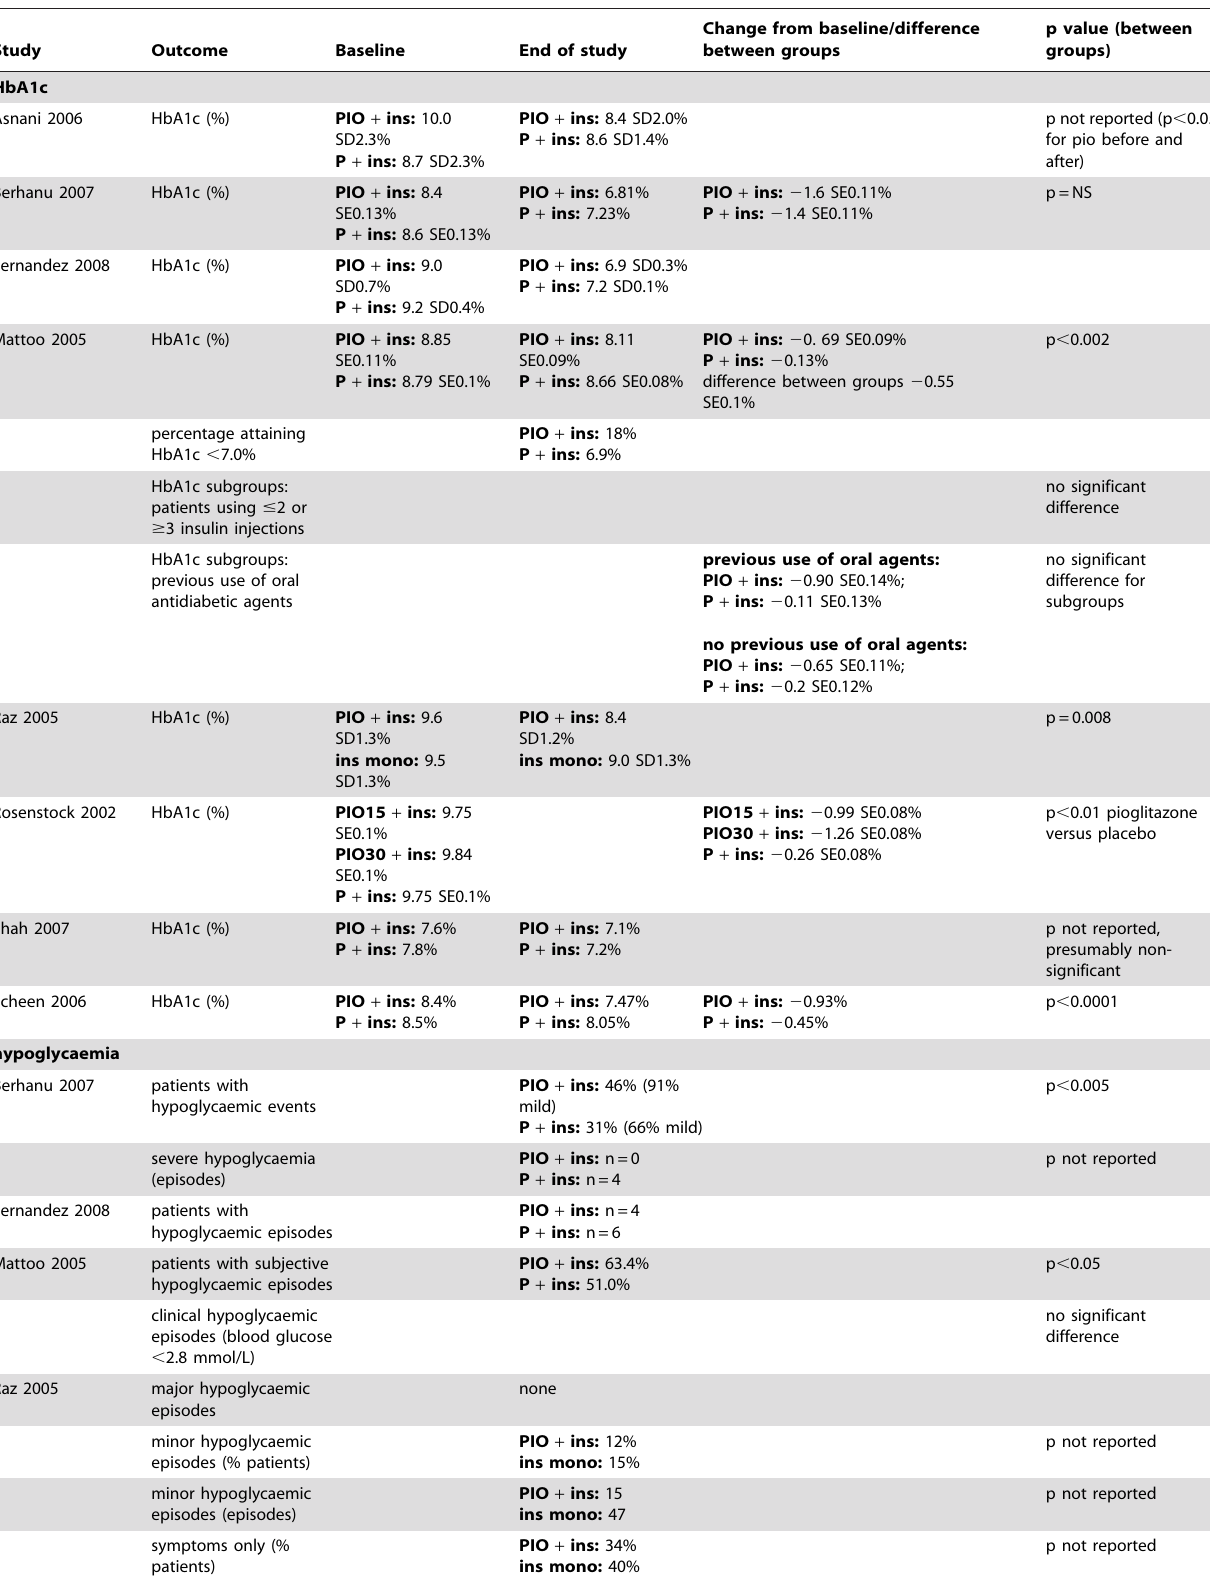
Table 3. Results of included